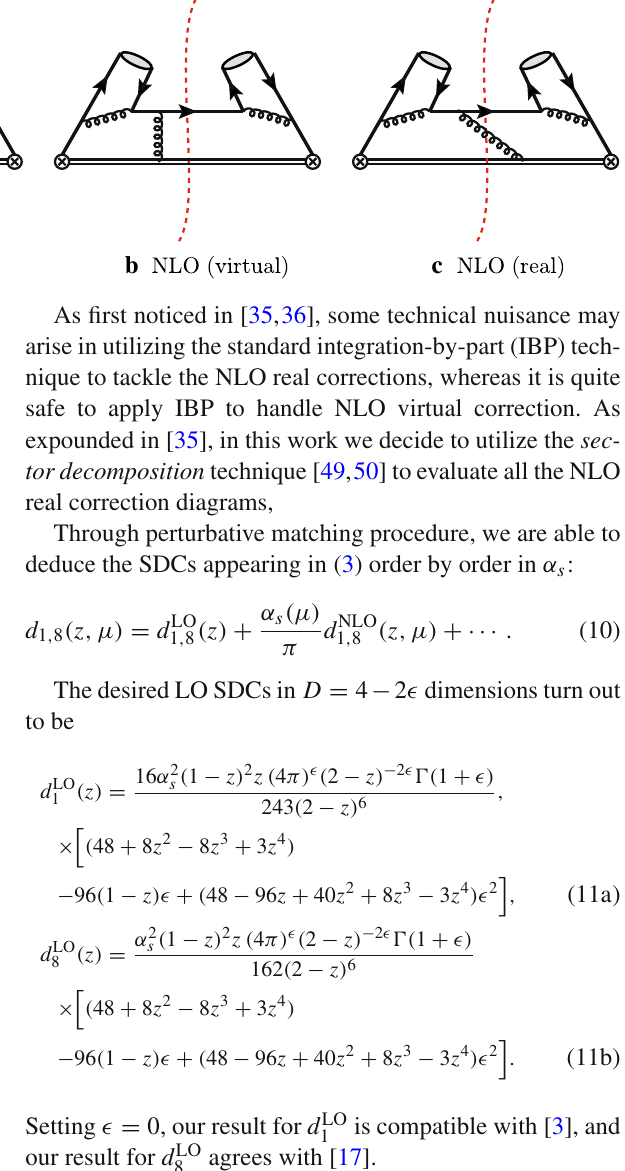
Fig. 1 Some representative Feynman diagrams for the charm quark fragmentation ( z ) at LO function D c → c ¯ c ( 1 S ( 1 , 8 ) 0 ) and NLO in α s . The cap represents the injected quark field operator, while the double line signifies the eikonal line